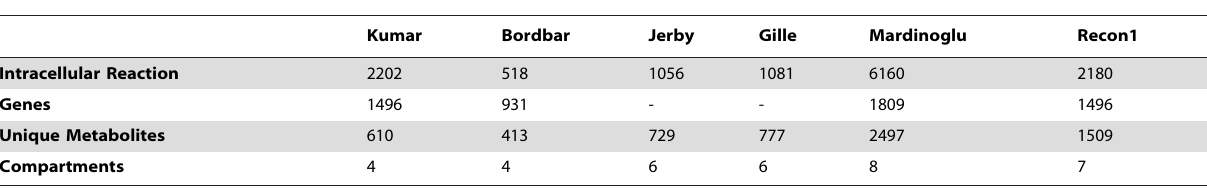
Table 1. A comparison of different models.